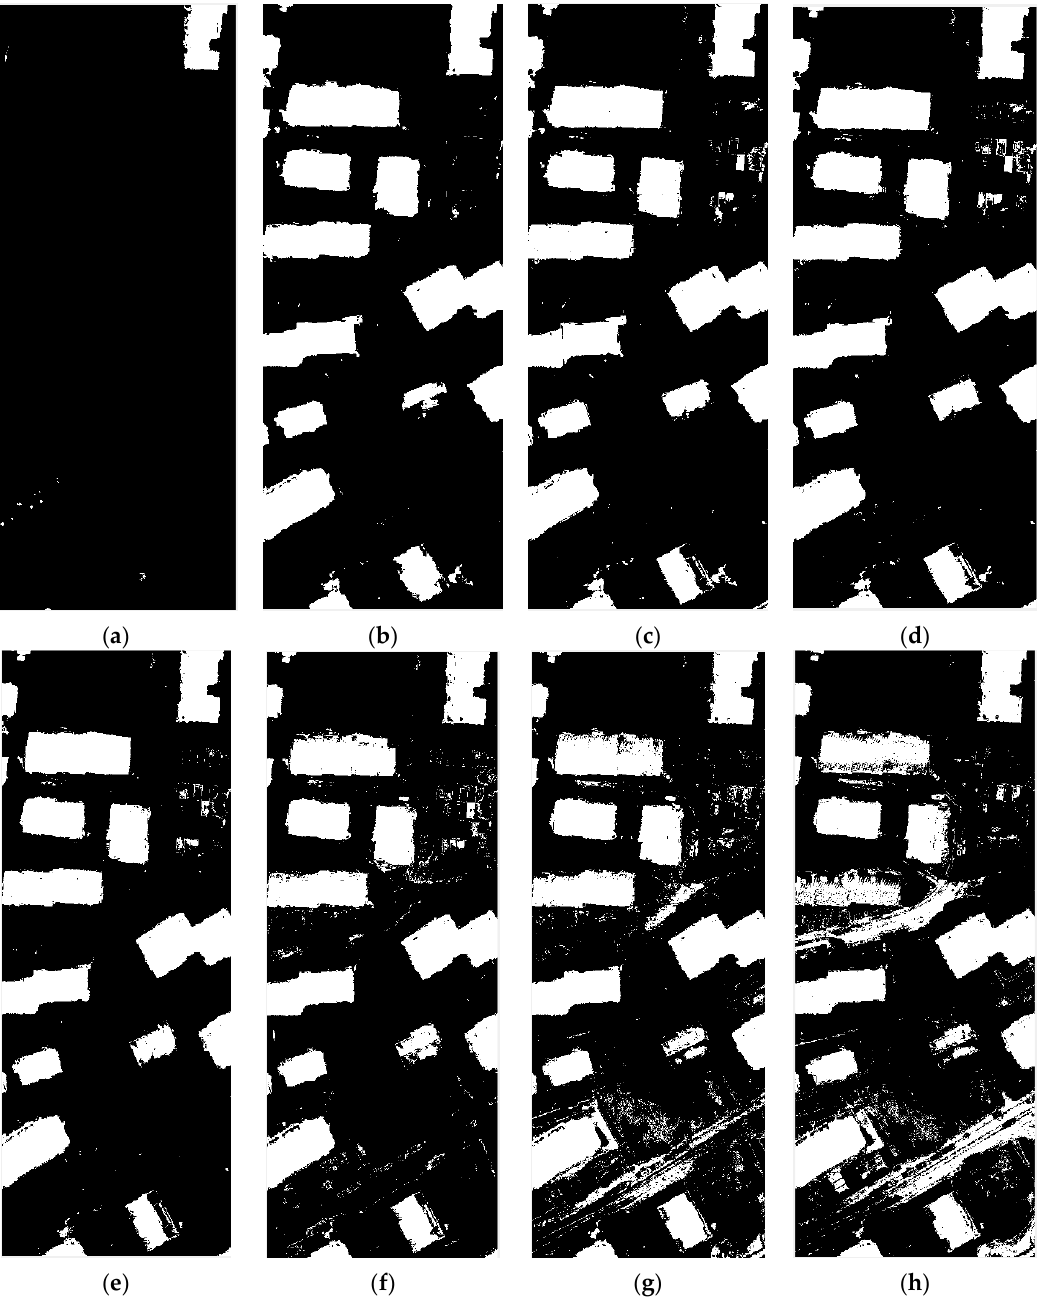
Figure 7. Results of different size of extraction: ( a ) 1000 points; ( b ) 6000 points; ( c ) 10,000 points; ( d ) 15,000 points; ( e ) 30,000 points; ( f ) 100,000 points; ( g ) 150,000 points; and ( h ) 600,000 points.